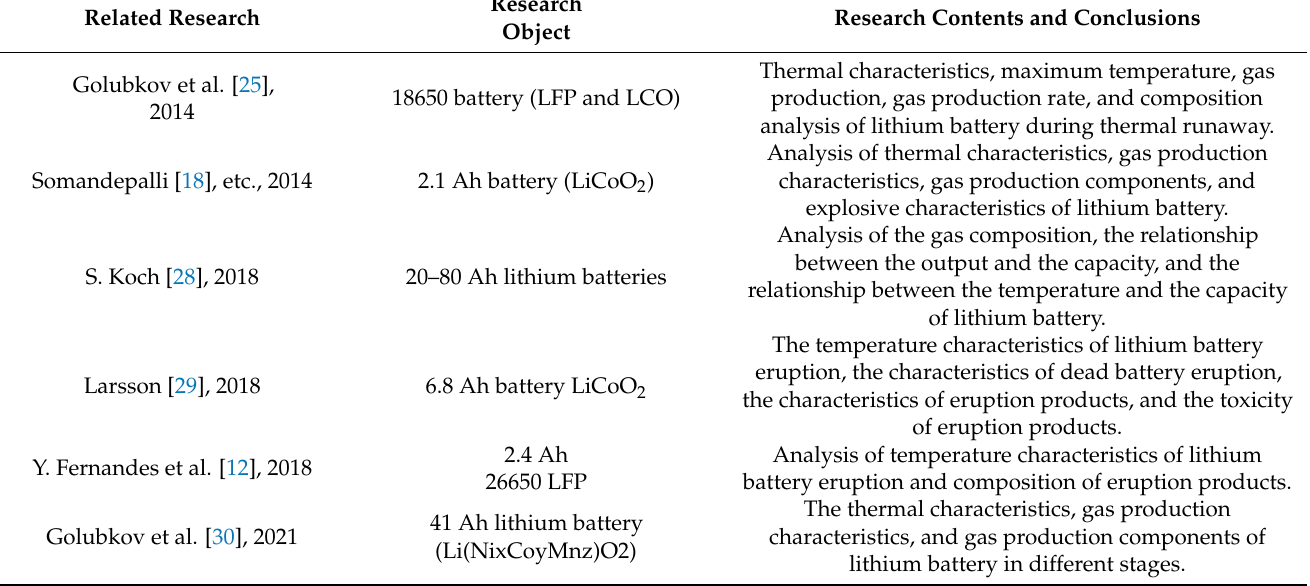
Table 2. Research status of thermal runaway eruption of lithium-ion